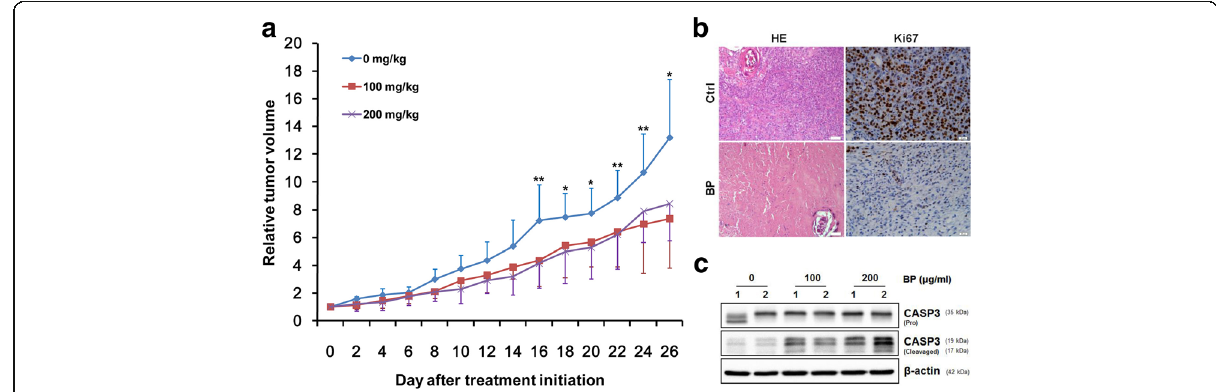
Fig. 7 BP inhibits xenographic growth of BFTC cells in NOD-SCID mice. a Approximately 5×10 5 BFTC cells were injected into the dorsal subcutaneous tissue of NOD-SCID mice. When the tumor reached 100 – 250 mm 3 , BFTC tumor-bearing mice were administrated s.c. with vehicle control or 100 to 200 mg/kg BP on days 0 – 4 for 5 days. The relative tumor volumes of the control and the BP-treated groups are shown as means ± S.D. of tumor volume at each time point. b Tumor tissue sections with HE staining. The proliferation marker ki67 were immuno-histochemically identified in the control and the BP-treated groups. Expression of cleavaged caspase-3 in the BFTC xenograft tumor tissue was up-regulated after BP administration as compared to